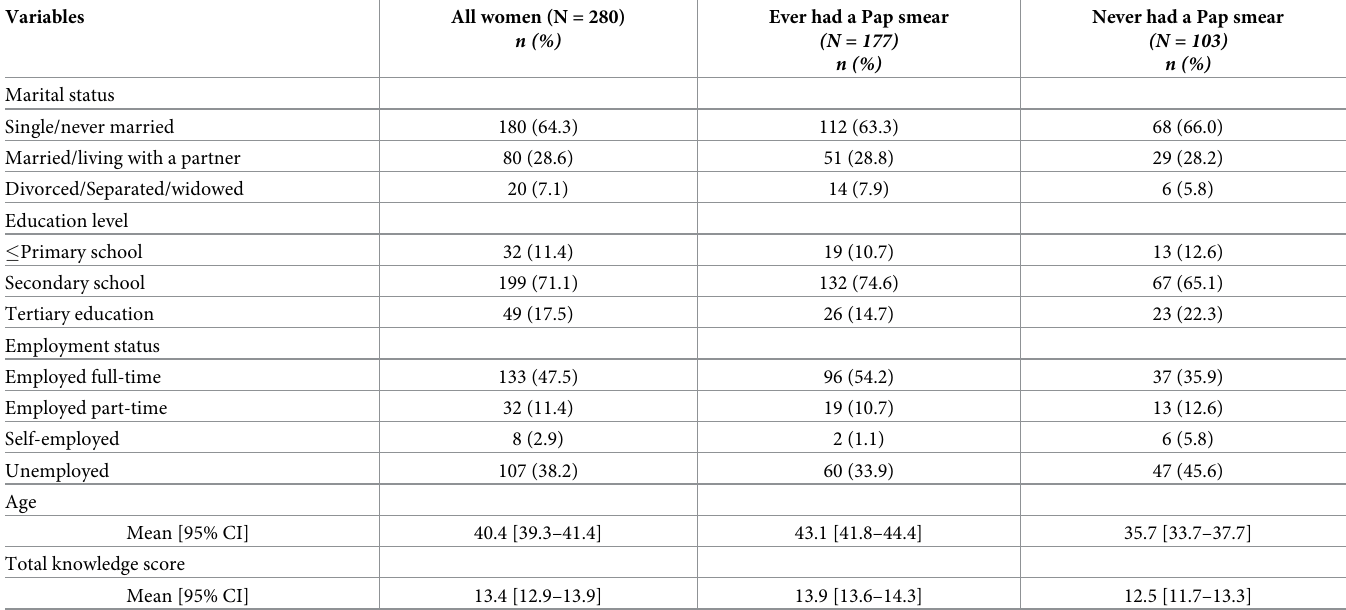
Table 1. Socio-demographic factors and knowledge scores by Pap smear